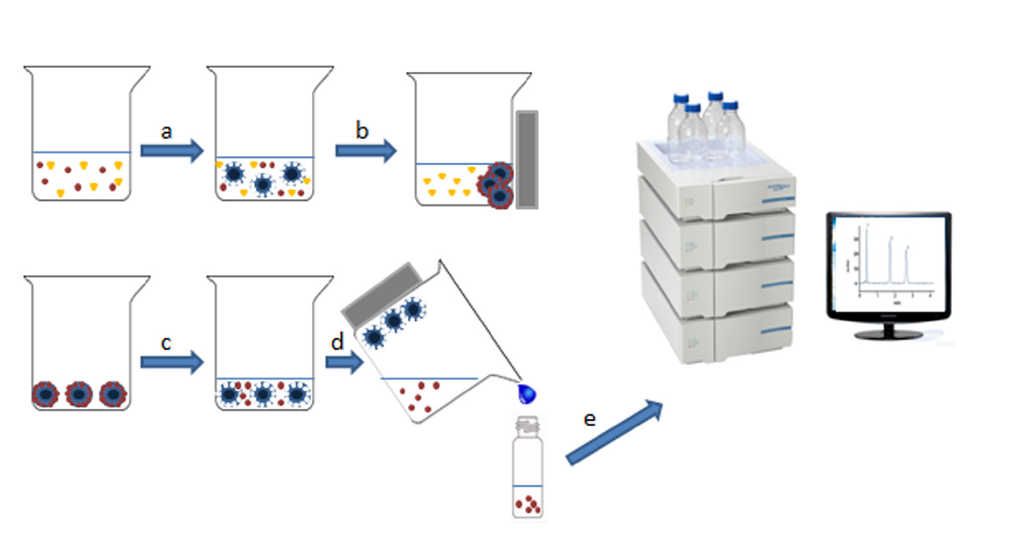
Figure 5: A scheme of the extraction process using magnetic molecularly imprinted polymers: a – addition of MMIP to the sample; b – separation of MMIP from the sample with a magnet; c – analyte desorption; d - separation of MMIP from the analyte solution; e - analysis. Table 2: Examples of MMIP application in the analysis of biological